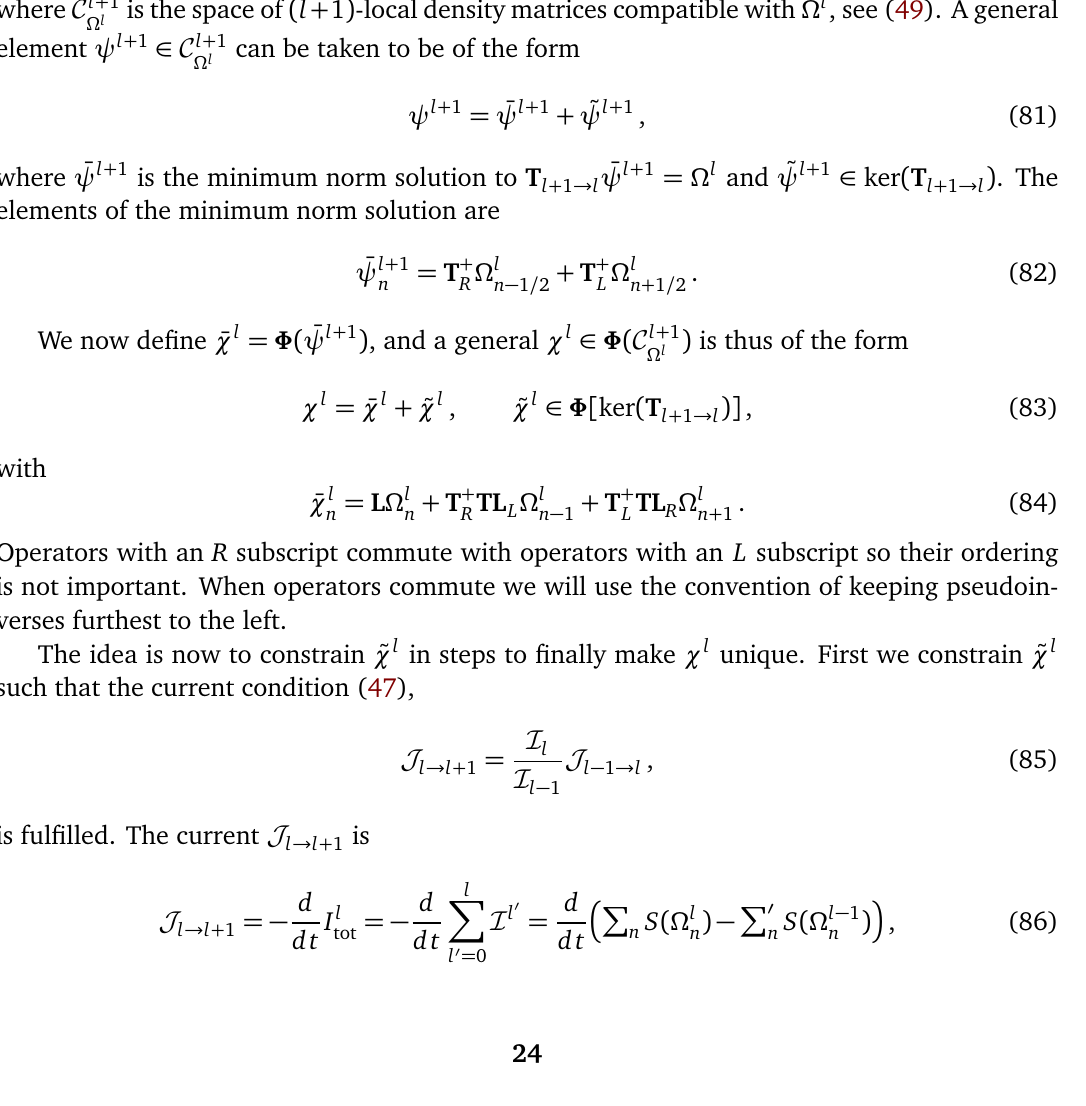
= (cid:80) ) − (cid:80) (cid:48) ) , where (cid:80) (cid:48) l I ( Ω l I ( Ω l − 1 indicates n n n n n tot I